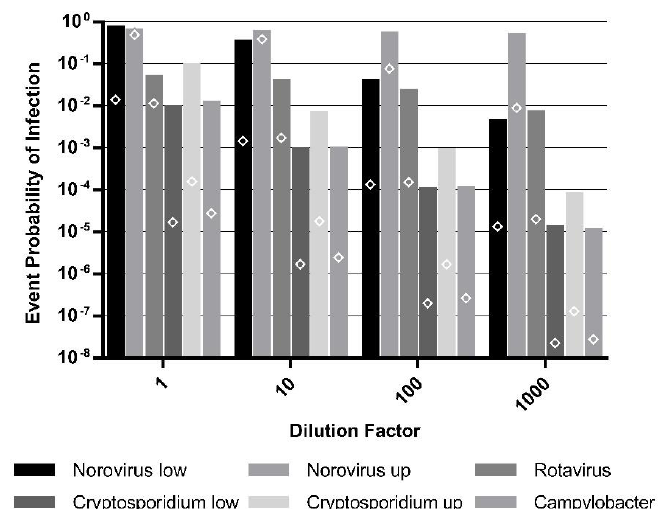
Figure 1. The 95th percentile event probability of infection for ingestion of domestic, non-potable reclaimed wastewater contaminated by domestic wastewater (bars) or domestic, non-potable reclaimed greywater contaminated by domestic greywater (diamonds), both generated by a 1000-person residential collection system. The dilution factor is expressed as 1-part intrusion water: X parts total water. Both upper- (up) and lower- (low) bound dose-response presented. Similar to the results in Section 3.2.1, the median risks (not shown) were zero for all pathogens except Norovirus (e.g., 8 × 10 −2 –5 × 10 −1 infections ppe for undiluted wastewater and 2 × 10 −4 – 1 × 10 −1 infections ppe for undiluted greywater from 1000-person collection systems) due to the low pathogen occurrence. The risk exceeded zero for Rotavirus, Cryptosporidium spp., and Campylobacter at the 80th, 89th, and 73rd percentiles, respectively (e.g., 1 × 10 −4 , 6 × 10 −6 –2.0 × 10 −5 , 7 × 10 −9 infections ppe for undiluted wastewater and 2 × 10 −5 , 2 × 10 −7 –2 × 10 −6 , 7 × 10 −10 infections ppe for undiluted greywater from 1000-person collection systems).